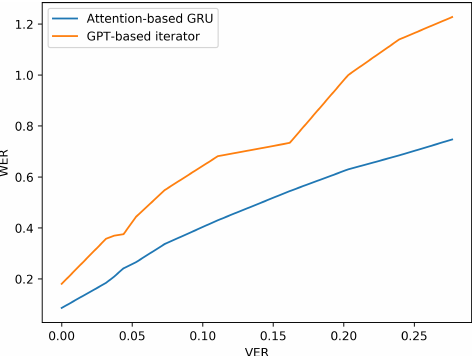
Figure 11. WER performance under varying noise levels (evaluation on LRS2 corpus).